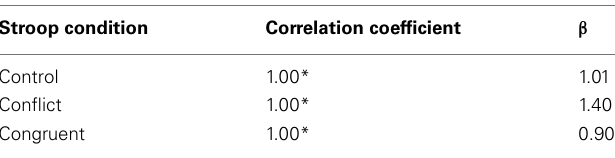
Table 1 | Fit of Piéron’s law against simulation data for single stage model with locked inputs.